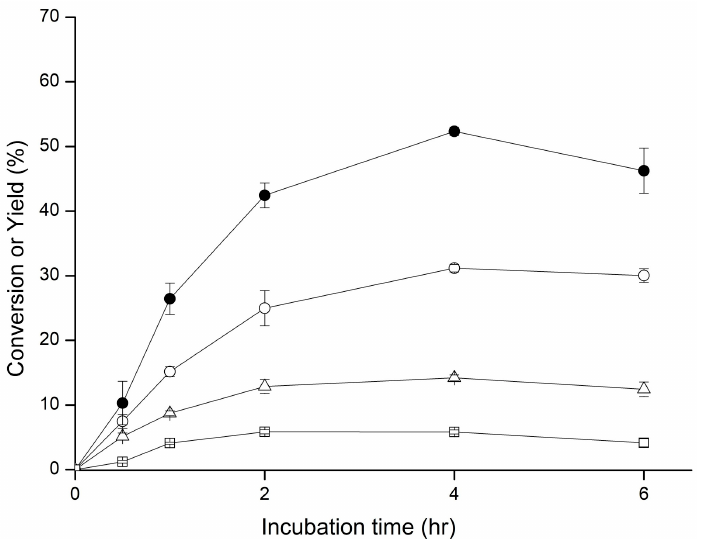
Figure 3. Time course of the conversion and of the products’ yields from GAA-15-G biotransformed by Toruzyme ® . Time course of the conversion (closed circle), and the products’ yields, GAA-G2 (open circle), GAA-G3 (open triangle), and GAA-G4 (open square), from the biotransformation of GAA-15-G by 0.3 KNU/mL Toruzyme ® with 20% of maltose at pH 5 and 60 ◦ C from 0 to 8 h calculated as described in Figure 2 was plotted. The results are presented as mean values ± standard deviations (n = 3).